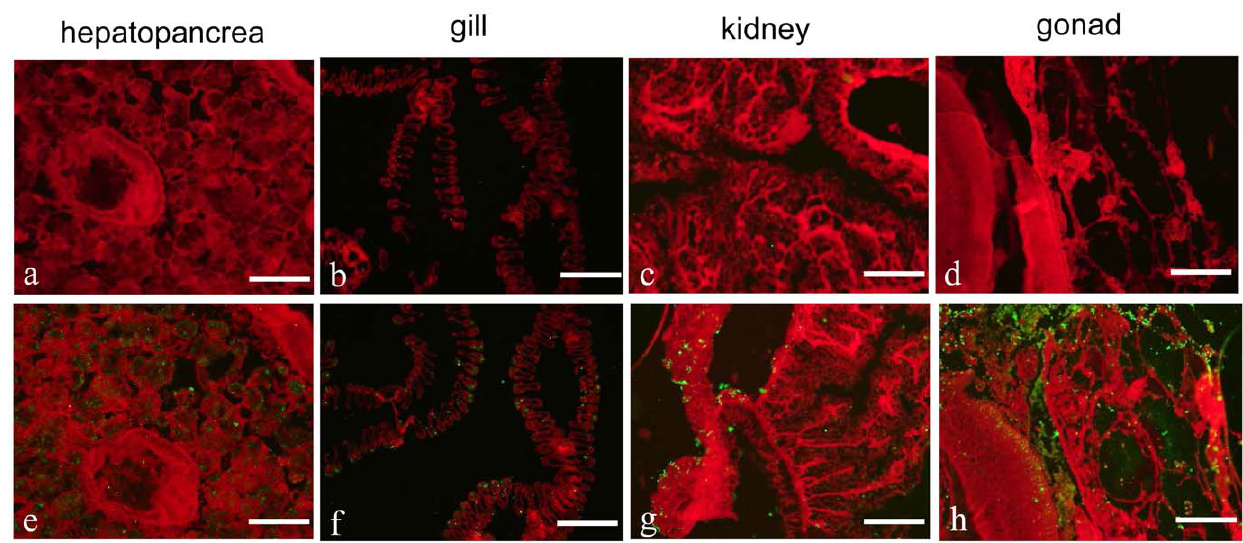
Figure 4. Localization of endogenous CfC1qDC in different tissues using rat polyclonal antiserum. Binding of antibody was visualized by Alexa Fluor H 488 dye conjugated secondary antibody (green), and the whole tissues were stained with EBD (red). Hepatopancreas (a and e); gill (b and f); kidney (c and g); gonad (d and h). All the bars represent 100 m m.